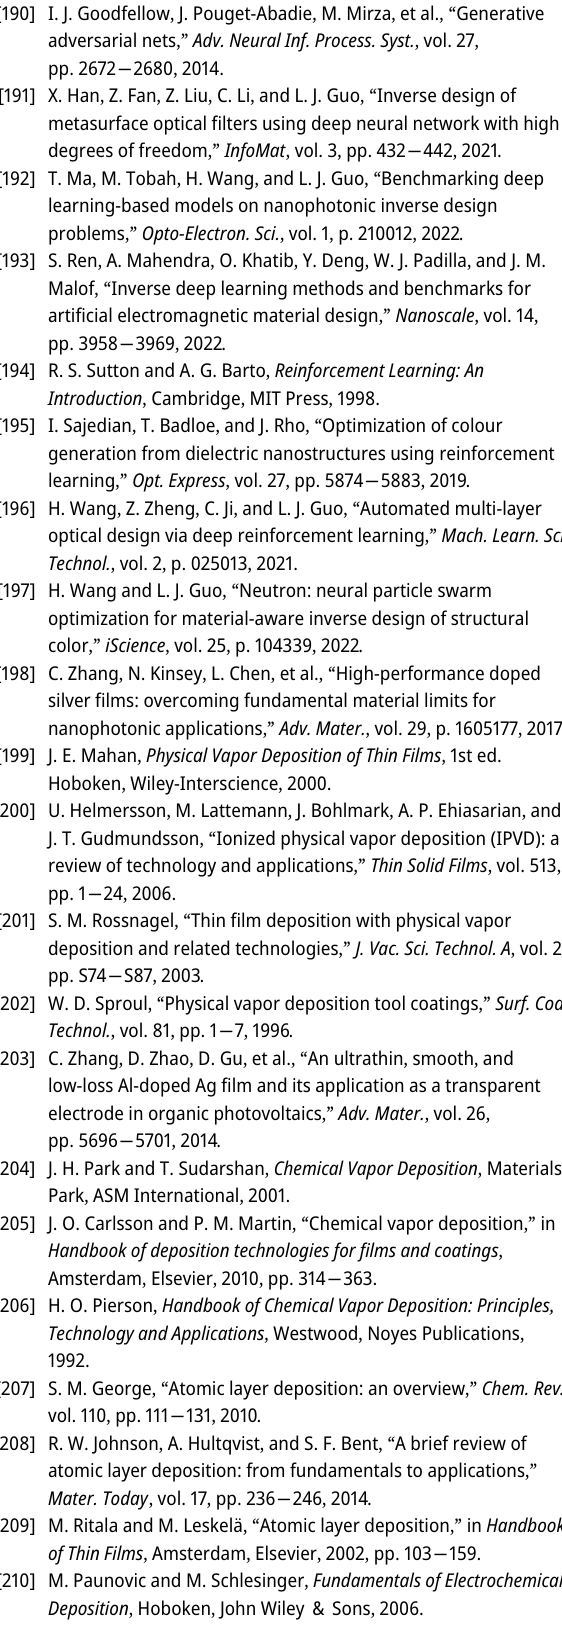
— 1076 D. Wang et al.: Structural color generation: from thin films to optical